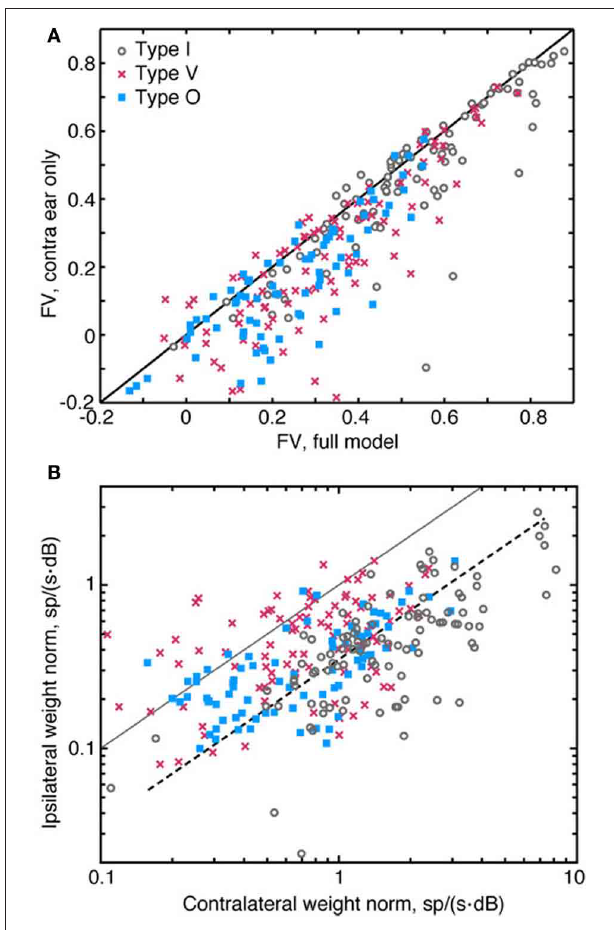
FIGURE 9 | Relative contribution of ipsilateral and contralateral weights. (A) Comparison of the prediction quality ( fv ) for a full 2nd-order binaural model (abscissa) and a model which assumes a purely contralateral input [i. e., S I ( f ) = 0 for all f , ordinate]. Data from one experiment showing little or no effect of the ipsilateral inputs are included in this plot. (B) Plot of the amplitude of the 1st-order weight vector in the contralateral ear (abscissa) vs. the weight amplitude in the ipsilateral ear (ordinate). The amplitudes of the weights are measured as the norm of 1st-order weight vectors (the square root of the sum of the weights squared). The solid diagonal line indicates where weight vector norms are equal in amplitude. The dashed line indicates where ipsilateral norms are one-fourth the size of contralateral norms. Note the use of logarithmic axes in (B) . Also note that data points shown in (A) and (B) were aggregated across all sound levels of stimulus